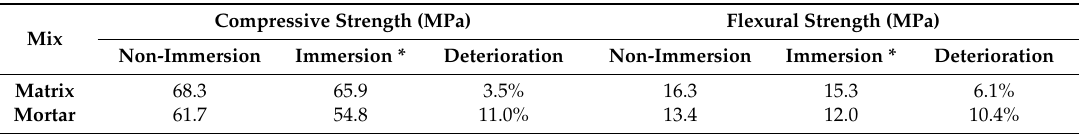
Figure 1. Evaluation of alkali resistance of the matrix: ( a ) dipping; ( b ) curing (thermo-humidistat). Table 3. Alkali resistance results.